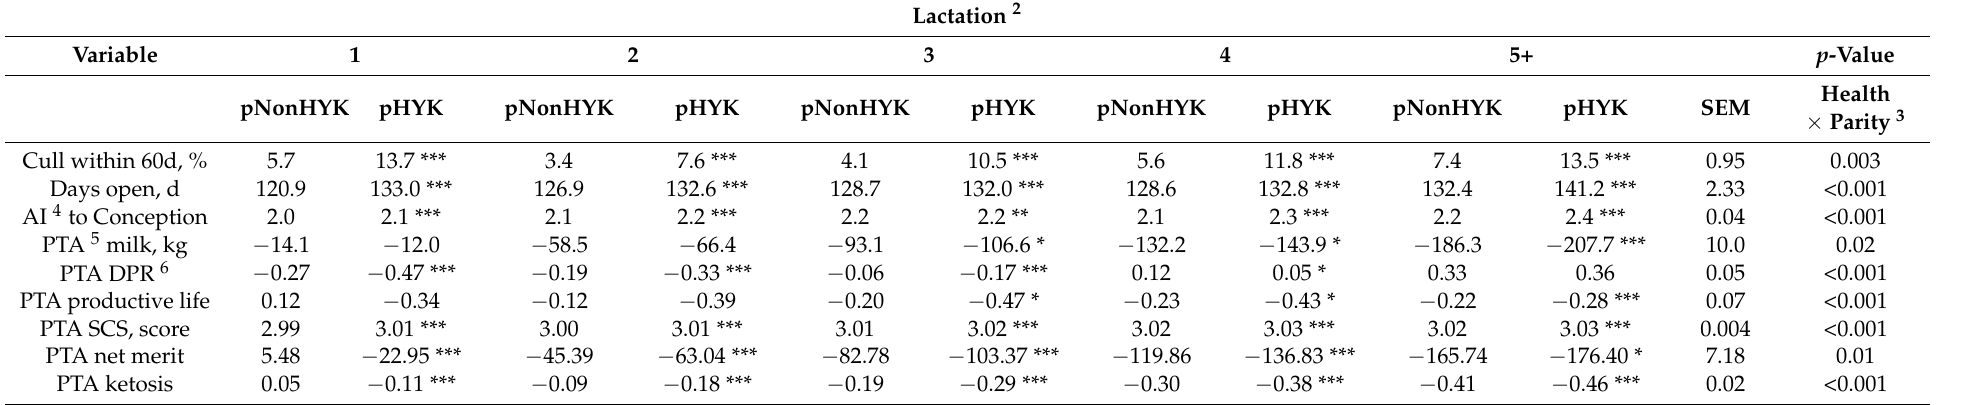
Table 3. Parity by Predicted Hyperketonemia (HYK) Status Interaction on Management Outcomes and Genetic Predictions for Cows between 5 and 20 Days in Milk and Classified into Predicted Hyperketonemic (pHYK) or Predicted Nonhyperketonemic (pNonHYK) Using Multiple LINEAR regression 1